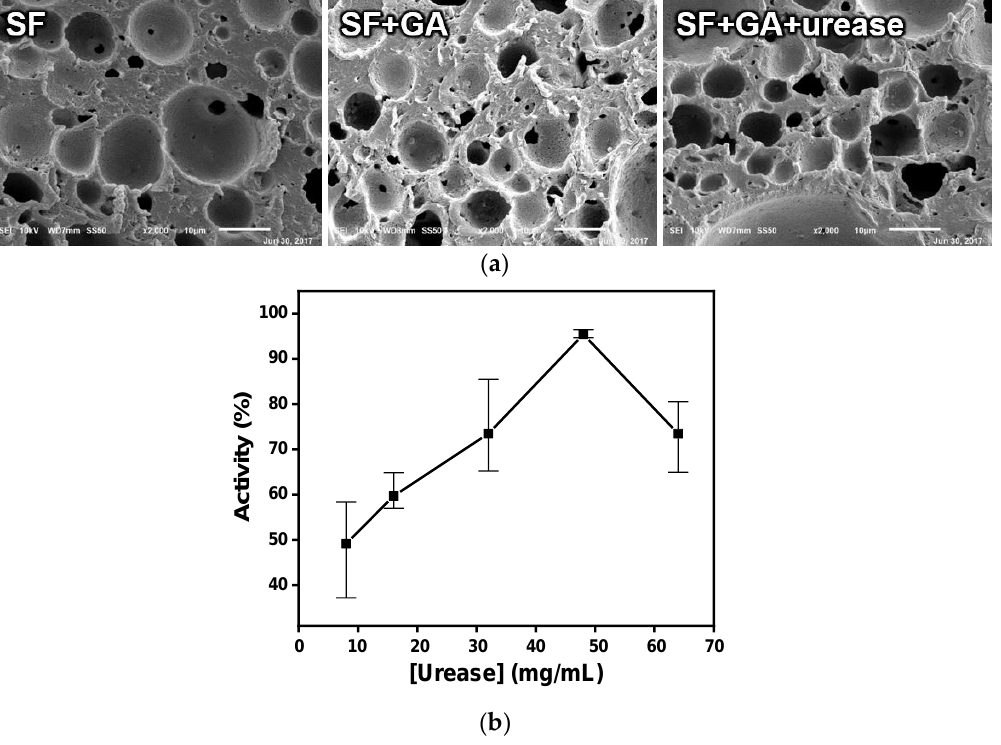
Figure 2. ( a ) The microstructural topography changes during the urease immobilization process on porous SF membrane (GA: glutaraldehyde). ( b ) Urease immobilization efficiency according to the treated urease concentration.